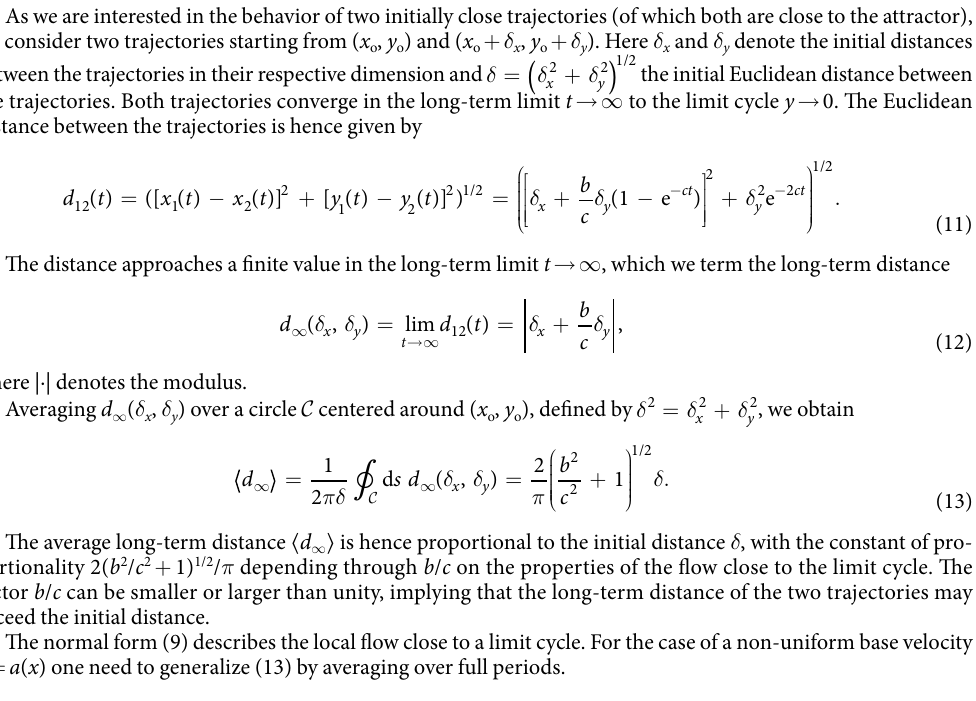
= + = −   x by y cy , (9) the Cartesian normal form of a limit cycle. The parameter a hence represents the base speed of the flow along the limit cycle, b the rate with which the flow parallel to the limit cycle changes with the distance y from the limit cycle, and c the time scale needed to relax to the attractor. The solution ( x ( t ), y ( t )) of the linearized system with the initial conditions ( x , y )( t = 0) = ( x o , y o ) is given by